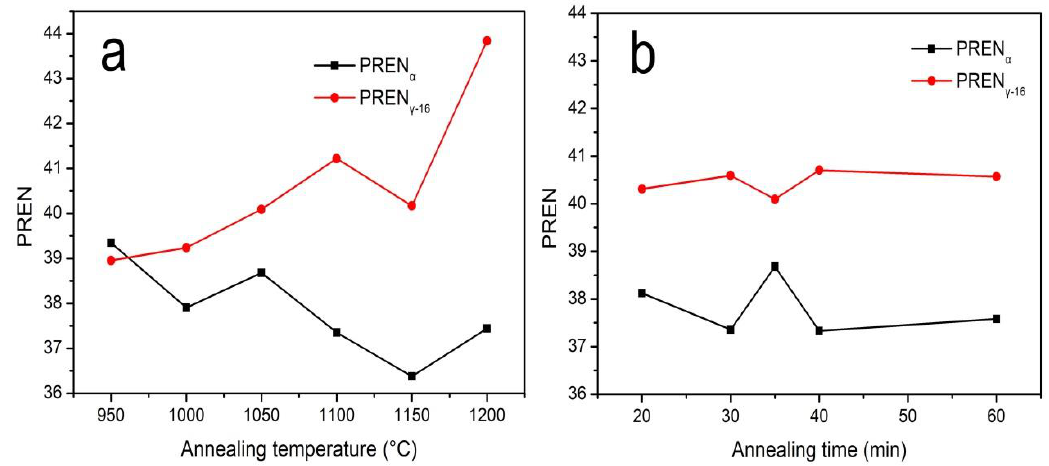
Figure 15. The PREN values of S32750 annealed at different ( a ) temperatures and ( b ) times.